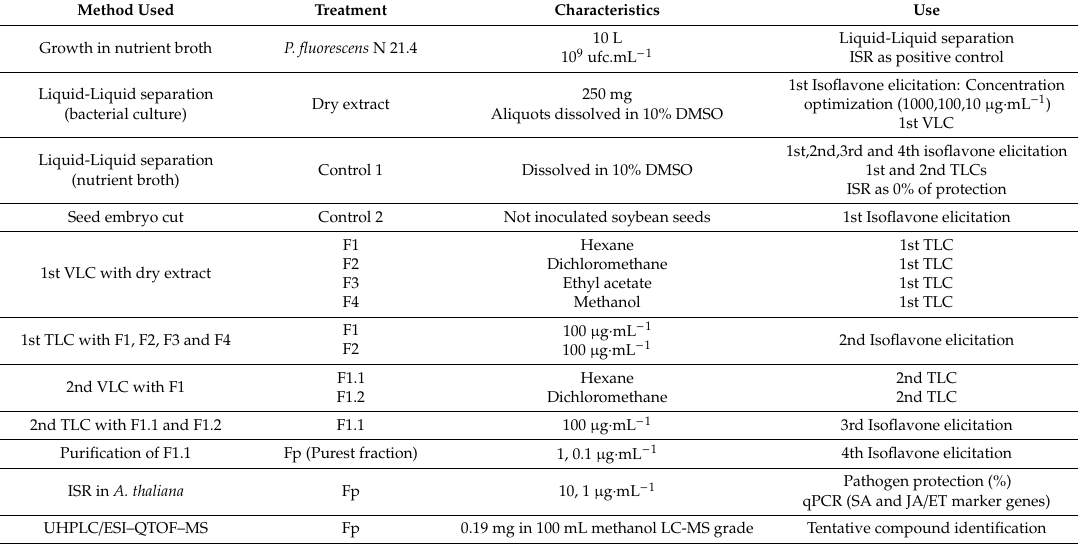
Figure 1. Representative scheme of the sequential extraction, fractionation and purification of the metabolic elicitors of P. fluorescens N 21.4. Shown are the growth of the bacterium in nutrient broth, the liquid–liquid phase separation with n -hexane, the process of fractionation and purification by two sequential vacuum liquid cromatographies, the four elicitation experiments of isoflavone metabolism, the ISR experiment in A. thaliana and the final compound identification by UHPLC. Table 1. Experimental design and treatments used.